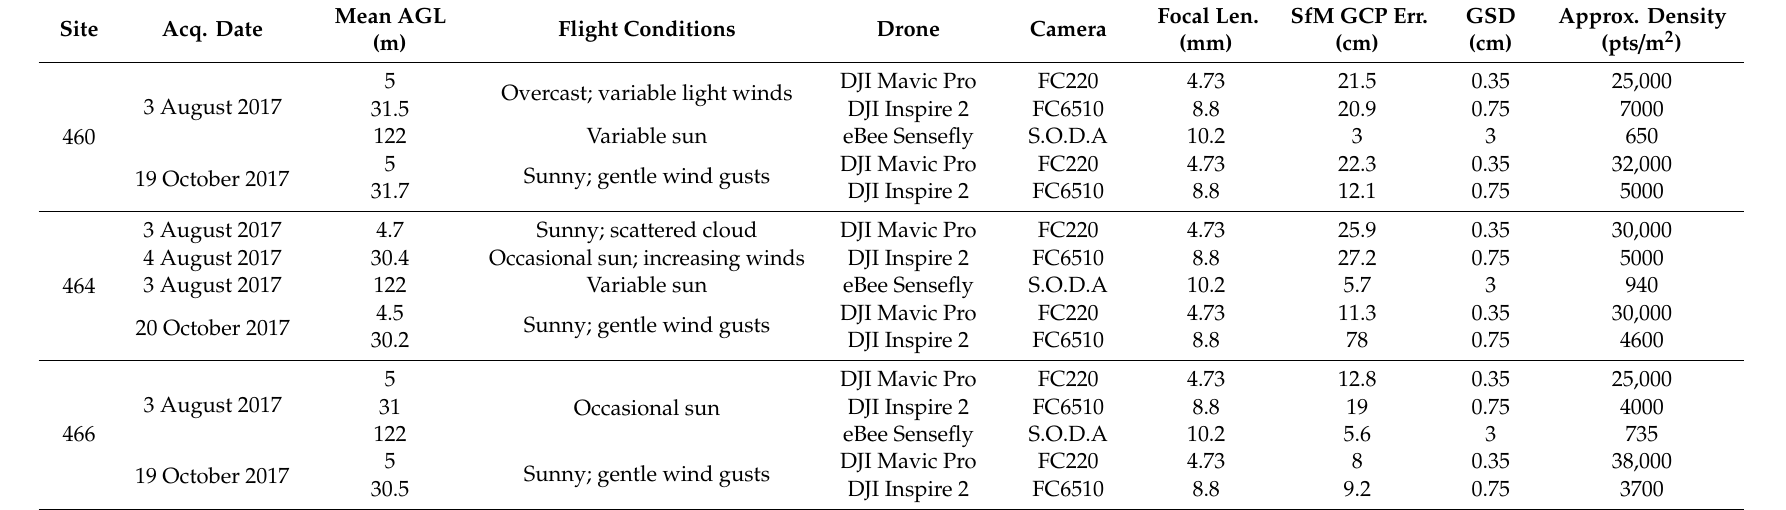
Table 2. Drone acquisition and processing parameters. Mean AGL = mean flight altitude above ground level, SfM GCP err = ground control point positional error from the structure-from-motion workflow, GSD = output ground sampling distance. The density column refers to the output drone-based image point cloud (DIPC) dataset.